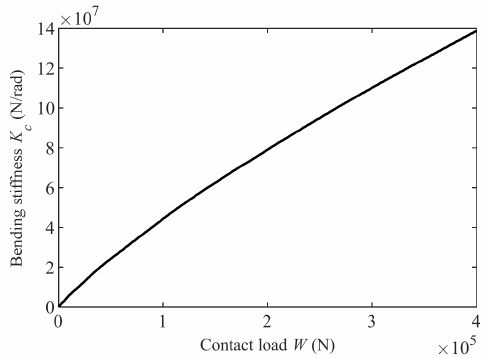
Figure 5. Relationship between contact load and bending stiffness.